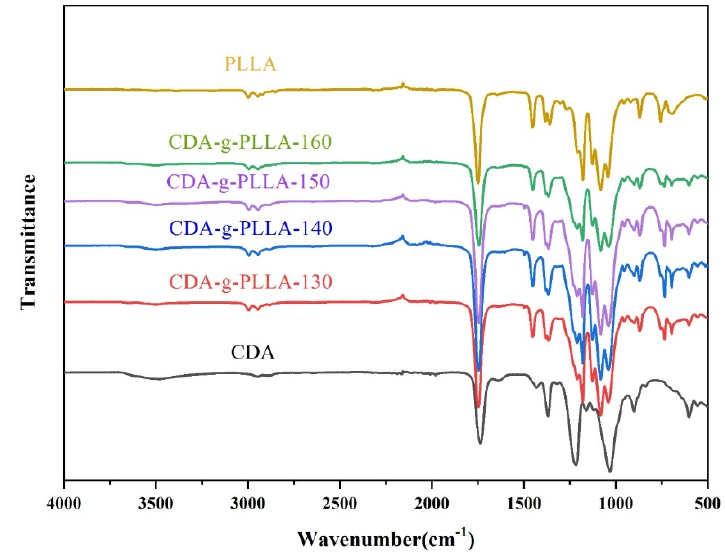
Figure 4. FTIR spectra of CDA, PLLA, and CDA − g − PLLA with different grafting temperatures.